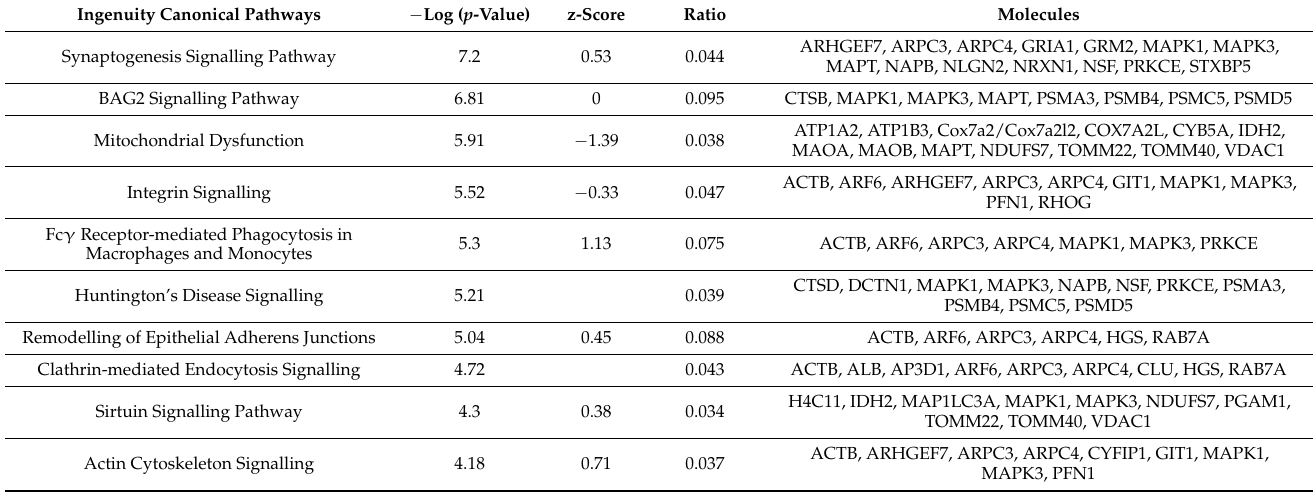
Figure 6. MnTMPyP applied in normoxia conditions modulates aspects of synaptogenesis, cellular stress and mitochondrial respiration. ( A ) Volcano plot showing significantly changed ( p < 0.05) proteins across the two groups. The most dramatically altered proteins (log2(Fold Change) > 2) are implicated in endocytosis (Scamp3), antioxidant activity (Nit1), synaptic development and plasticity (Nrgn). ( B , C ) Network enrichment analysis shows two networks of equal significance ( p = 1.00 × 10 − 48 ), one with downregulation of proteins implicated in apoptosis, endosomal trafficking and mitochondrial function ( B ), and the second centred on the downregulation of the protein tau, essential for maintaining neuronal polarity ( C ). Table 3. Ingenuity pathway analysis of normoxia-treated CA1 slices following MnTMPyP admin- istration, compared to vehicle-treated normoxia. Ingenuity-generated associated canonical path- ways, ranked by − log ( p -value), with the top three pathways centred on synaptogenesis signalling ( p = 6.3 × 10 − 8 ), cellular stress (BAG2) ( p = 1.5 × 10 − 7 ) and mitochondrial function ( p = 1.2 × 10 − 6 ).